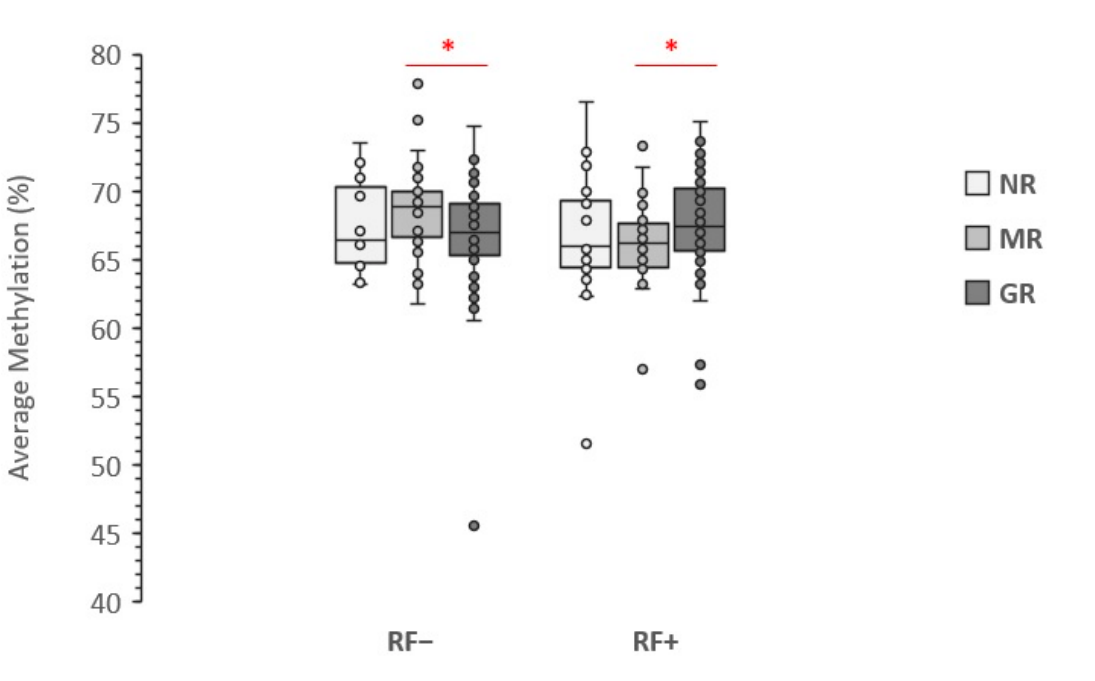
Instead, no methylation difference between GR and MR was observed among cases with either RF+ or ACPA+.